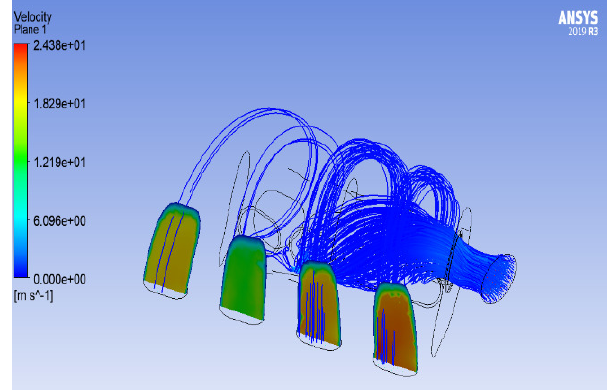
Fig. 5. Mesh resolution of 0 for an inlet velocity of